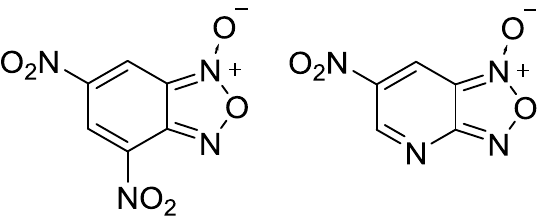
Figure 1. Selected examples of superelectrophiles.